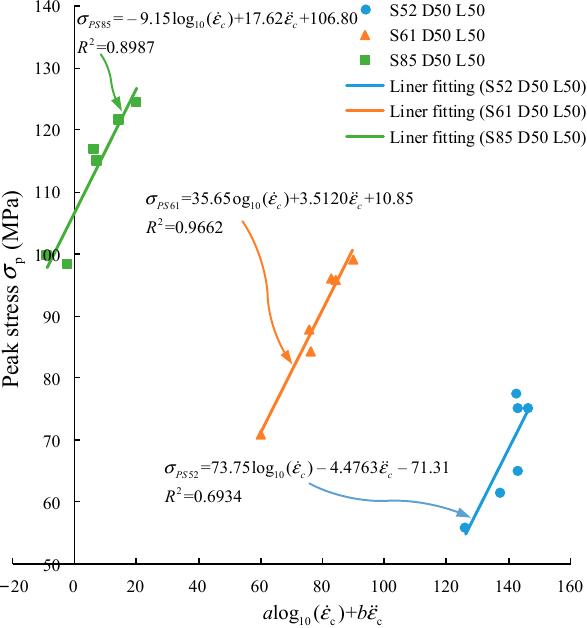
Figure 16. Comparison between the proposed model and the test results from Lee [47].